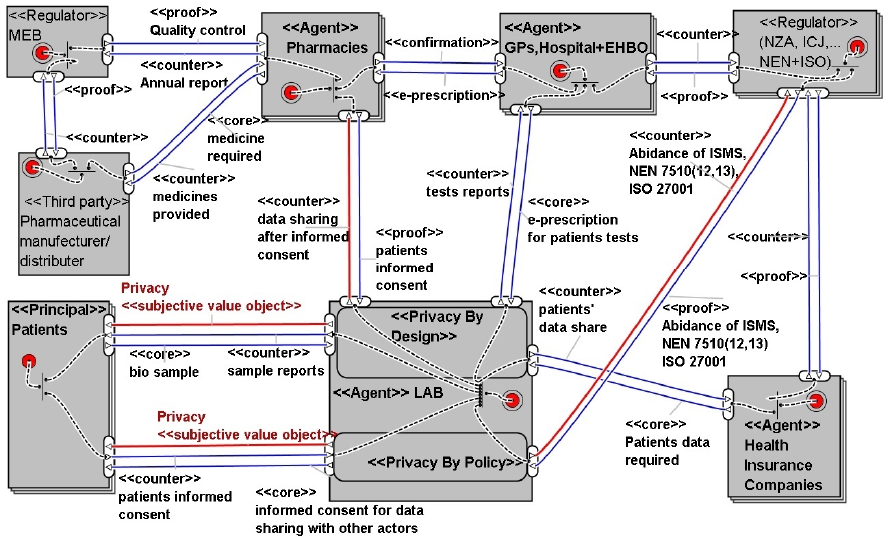
Figure 4. Privacy assurance evaluation at inter-organizational